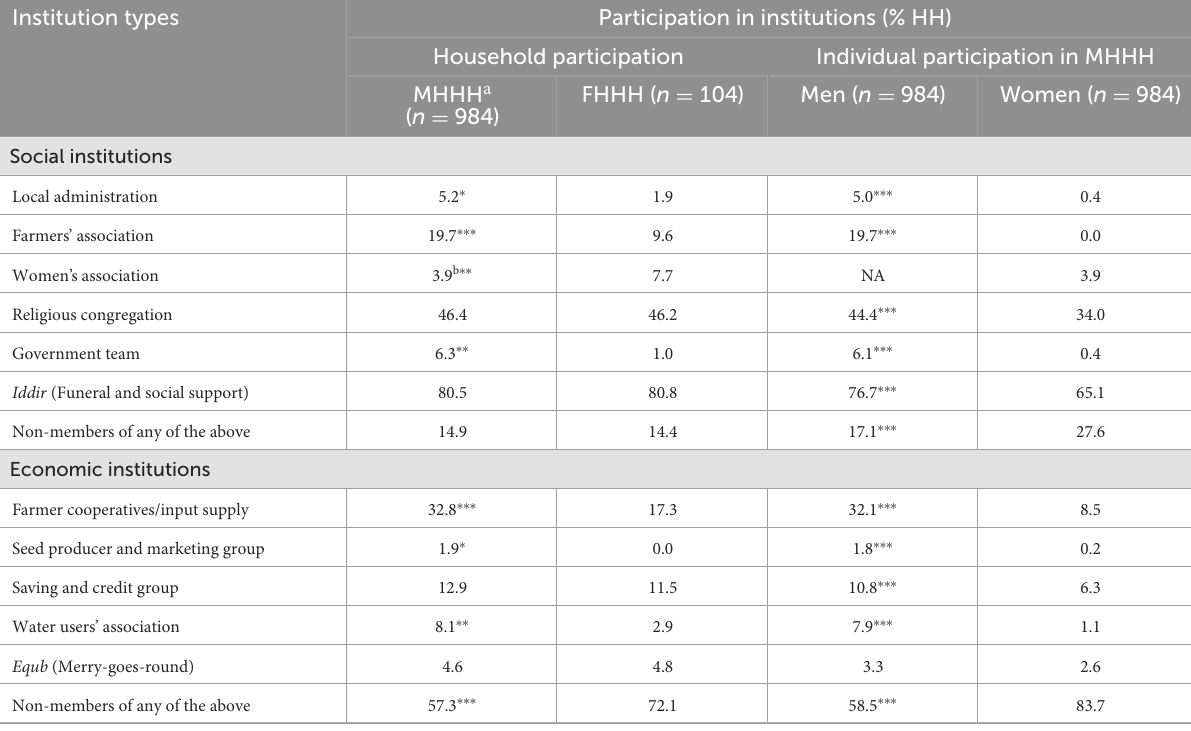
TABLE 4 Involvement of men and women from the MHHHs and FHHHs in social and economic institutions. Institution